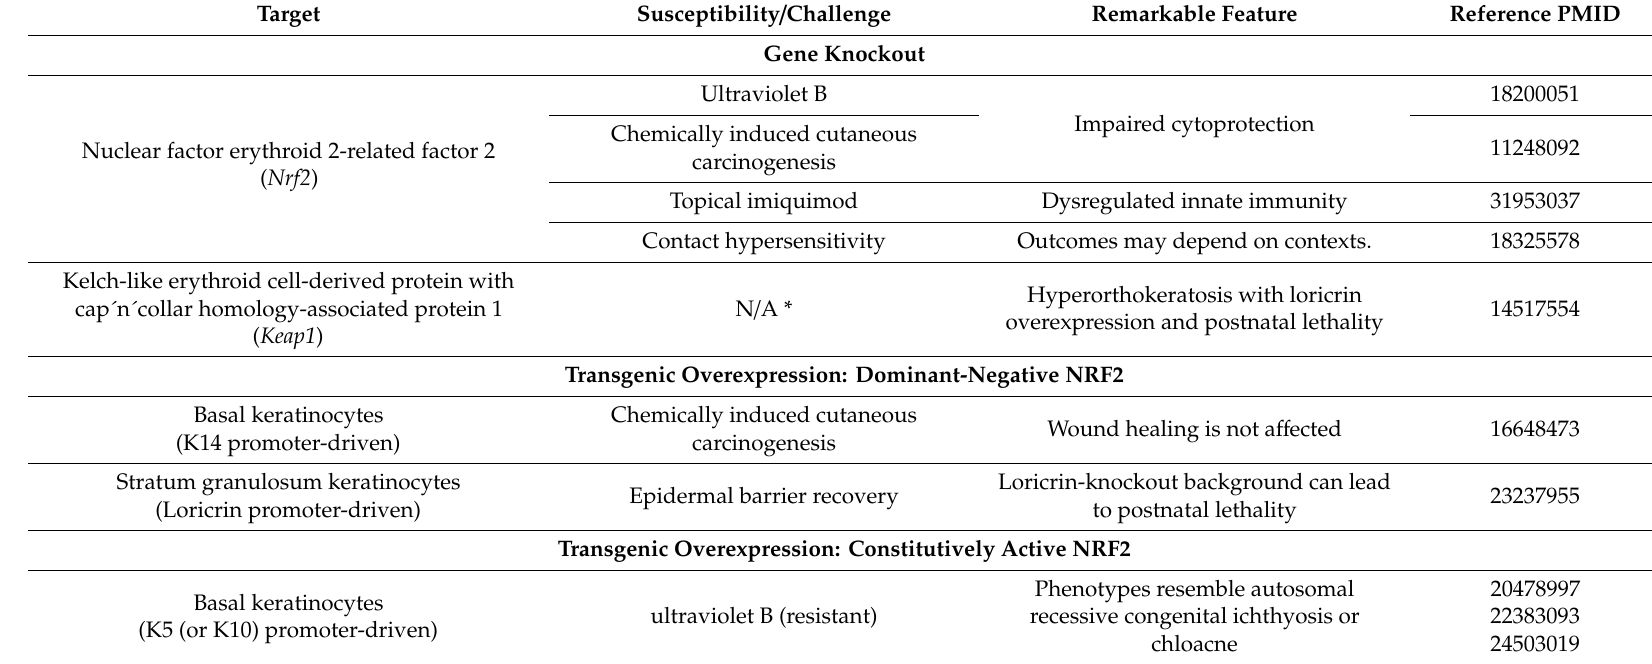
Table 3. KEAP1 / NRF2